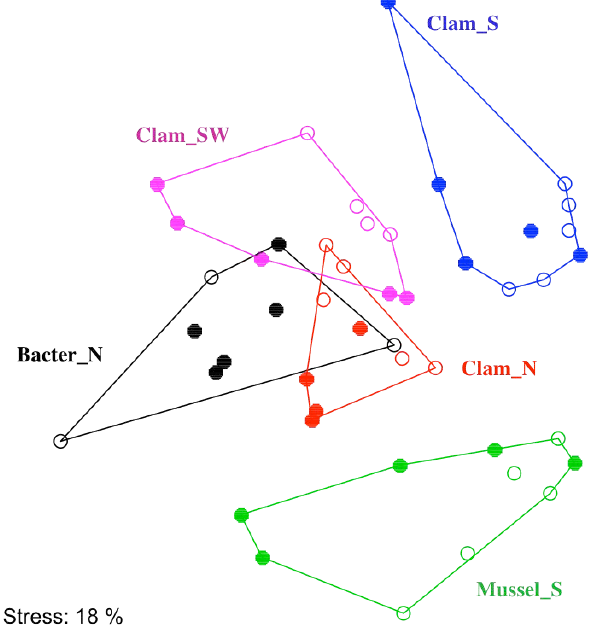
Fig. 4. Non-metric multidimensional scaling (NMDS) ordination plot (based on Bray Curtis distance matrix) of ARISA merged pro- files (2–3 PCR replicates were pooled to form a consensus pro- file). Ordihull grouping of samples (0–10cm) according to sam- pling location (samples from within the patches and the samples from the respective bare sediment were grouped together). NMDS stress 18%. Open symbols denote samples from the bare sediment sites – outside of the respective patch; closed symbols denote sam- ples from within the respective